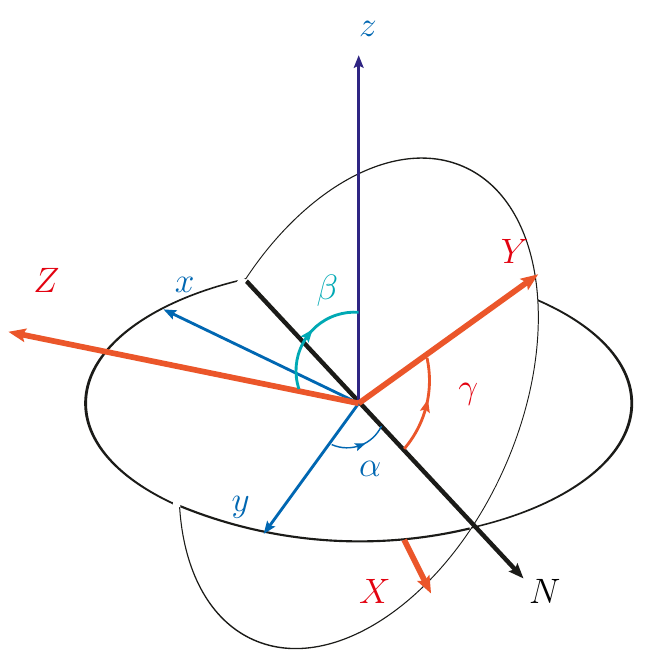
Figure 8 . Illustration of rotations to carry the n, K 0 xyz to the three body helicity system XY Z by the three Euler angles α, β and γ .